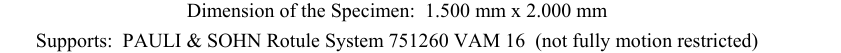
Table 3. Glazing